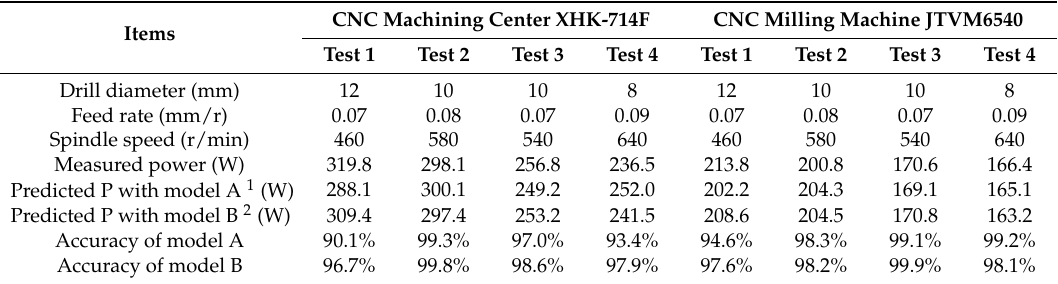
Table 7. The accuracy of the developed material-drilling power models of four test